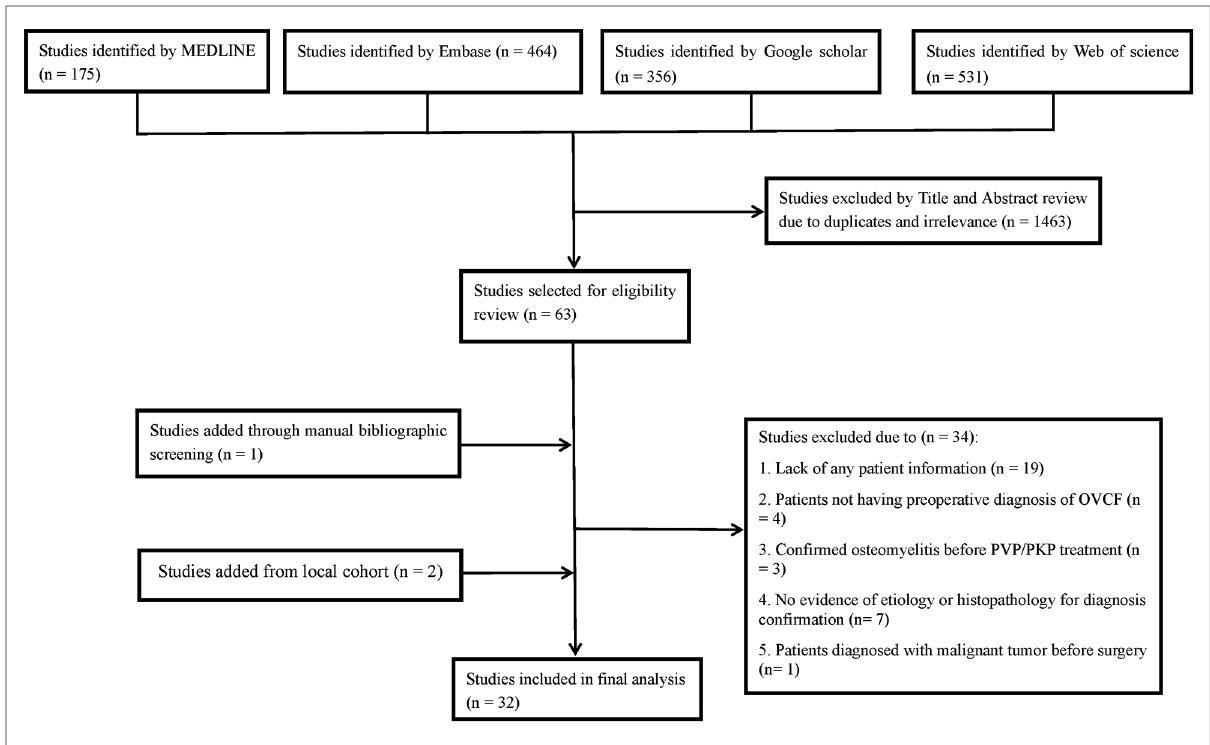
FIGURE 1 Flow diagram of literature search showing studies identi fi ed, included and excluded at each